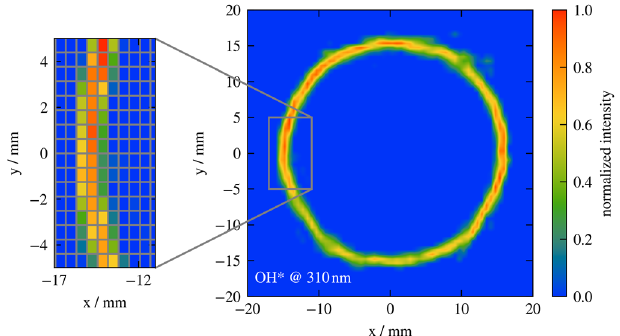
Figure 8. Typical reconstruction of a laminar methane/air diffusion flame obtained 1 mm above the nozzle exit (OH* @ 310 nm, exposure time 100 ms, λ 1 = 5, λ 2 = 10, CH 4 2.0 slm, air 10.0 slm). The inset is a magnification of the flame front superimposed with the numerical reconstruction grid (grid cell size 0.63 × 0.63 mm²).